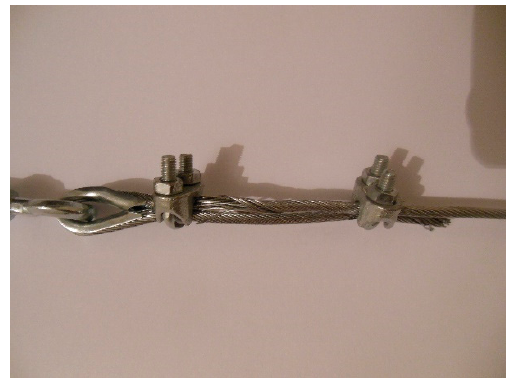
Figure 35. Failure mechanism of Specimen 4.